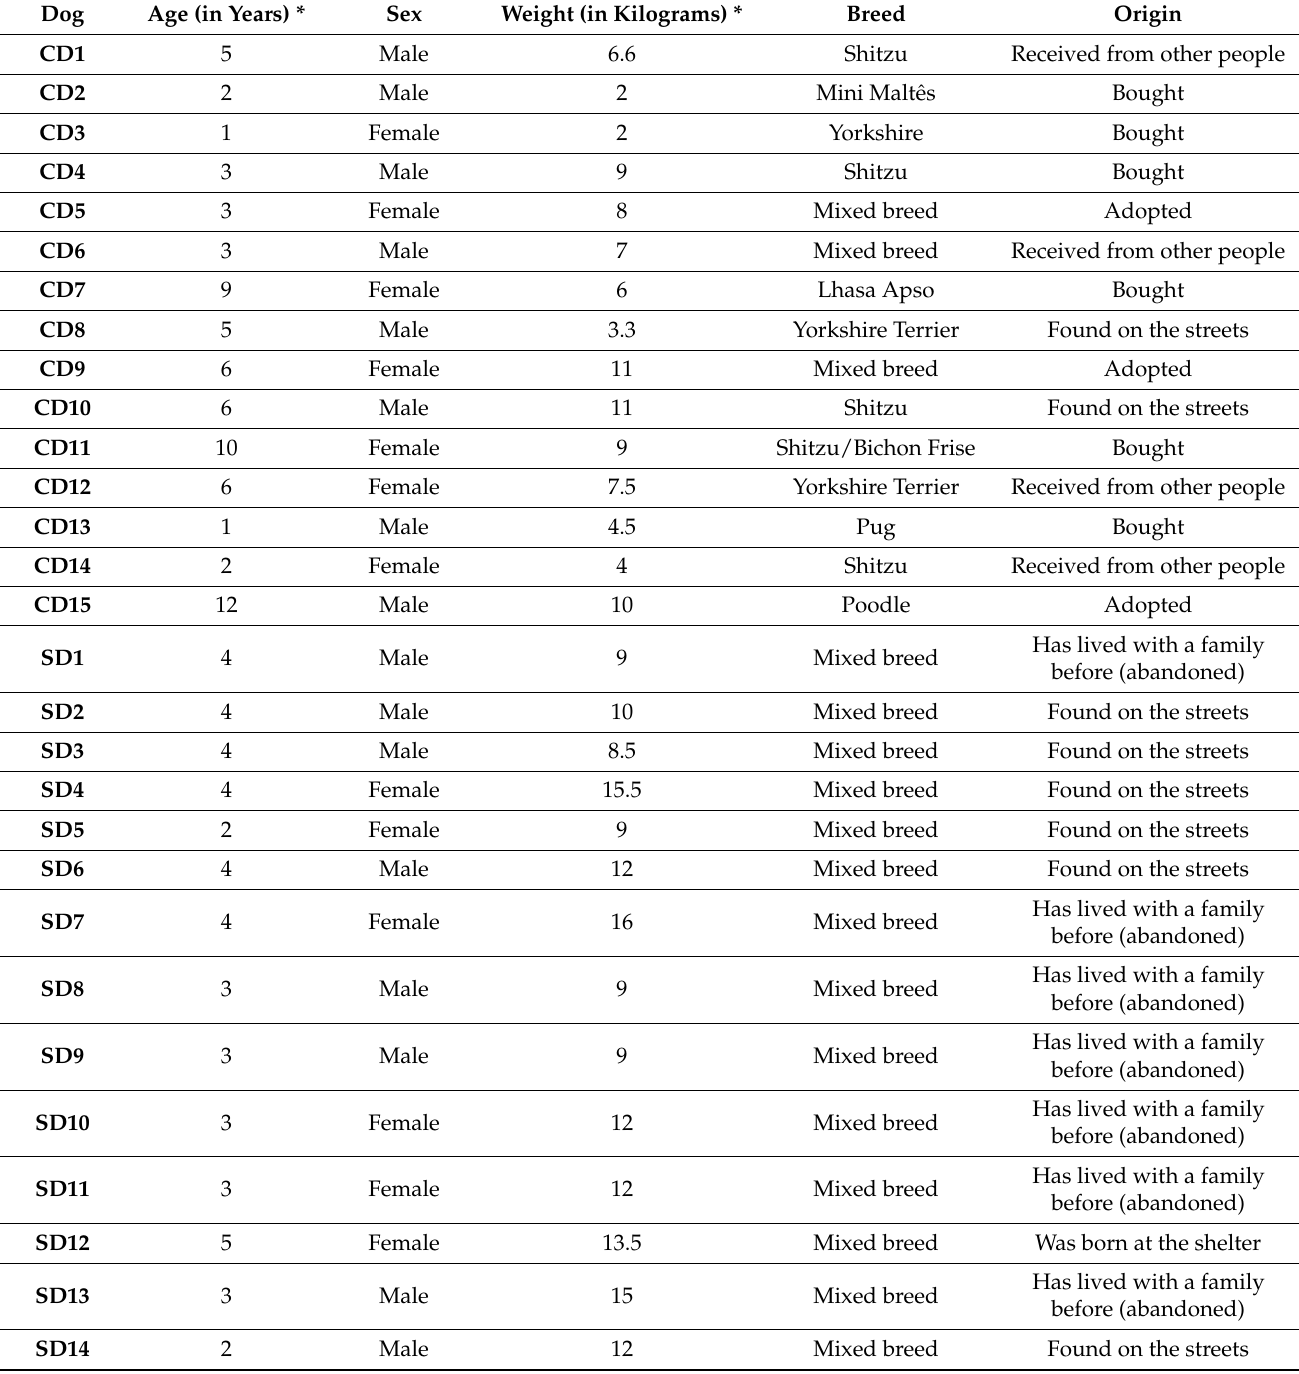
criteria for these dogs were that they should not know the proposed cues, nor be used to the physical and/or cognitive activities typical of training, and should have been living with their owners for at least six months. All dog-owners/shelter-keepers were instructed not to practice the cues with the dogs during the period in which the sessions were being held. Table 1. Age, sex, weight, breed and origin of the studied shelter dogs (SDs) and companion dogs (CDs). Dog Age (in Years)